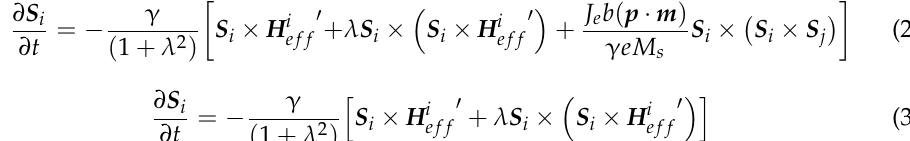
( a ) ( b ) Figure 3. Atomistic models structure of Gd 25 Fe 75 amorphous alloys with different sizes. ( a ) Gd 25 Fe 75 amorphous cubic alloy with side length of 1 nm, in which the spin of Fe atom is black and the spin of Gd atom is gray; ( b ) Gd 25 Fe 75 amorphous cubic alloy with side length of 10 nm. Table 1. The values and units of critical physical parameters in atomistic models of different sizes. Parameter Symbol Value Unit exchange constant of Gd–Fe J Gd − Fe − 1.09 × 10 − 21 J/link exchange constant of Gd–Gd J Gd 1.26 × 10 − 21 J/link exchange constant of Fe–Fe J Fe 2.835 × 10 − 21 J/link anisotropy energy constant k u 8.072 × 10 − 24 J/atom spin moment of Gd µ Gd 7.63 µ B spin moment of Fe µ Fe 1.92 µ B The magnetization dynamics are based on atomic-scale Landau–Lifshitz–Gilbert (LLG) equation. The spin variation of Fe sublattice is described by Equation (2), and the spin change of Gd sublattice is described by Equation (3): ∂ S